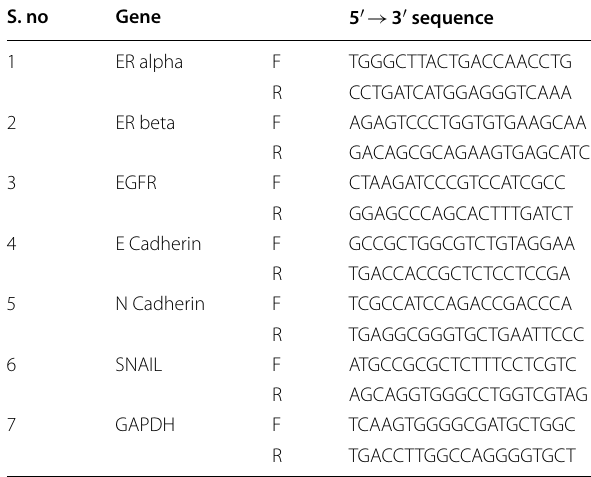
Table 1 List of primers used for quantitative real-time PCR of